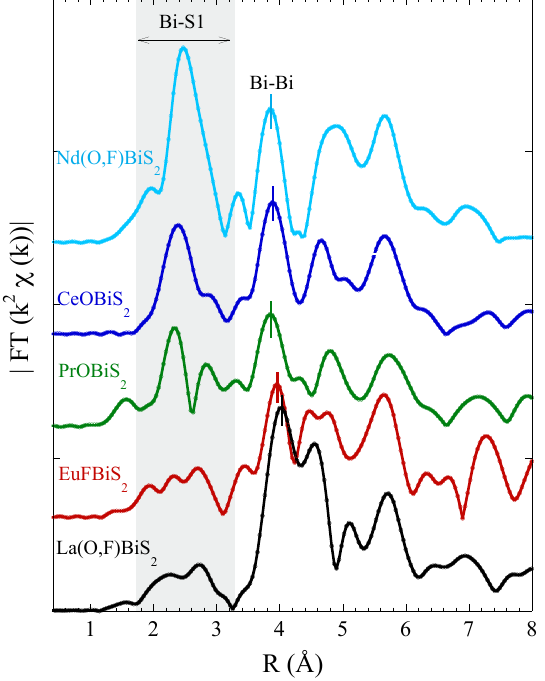
Figure 2. Fourier transforms (FT) magnitudes of Bi L 3 -edge k 2 -weighted EXAFS oscillations for RE(O/F)BiS 2 at 20 K. The FTs are performed using a Gaussian window in the k-range of 3–14.5 Å − 1